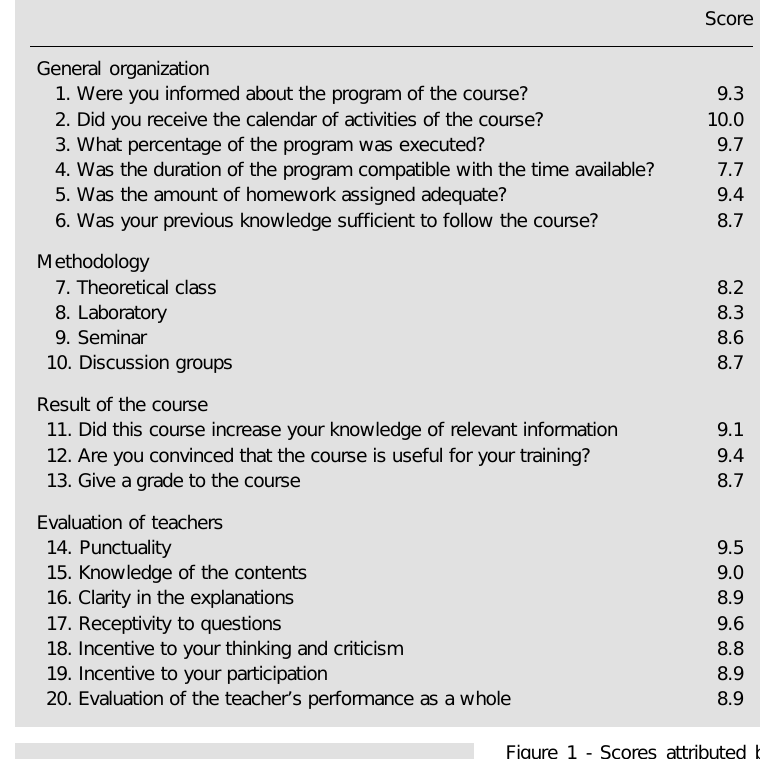
Figure 1 - Scores attributed by the students to the teachers of